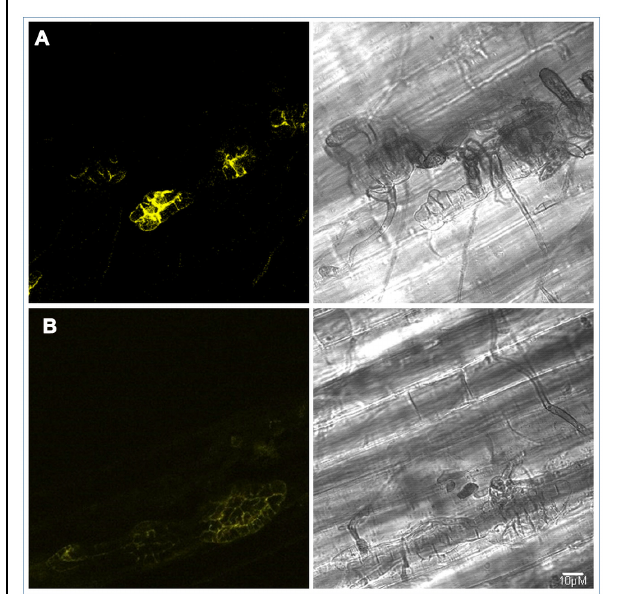
FIGURE 6 | PJK4:ALVi_Vi1_5: eYFP transformed isolate V. inaequalis Vi1 growing on apple hypocotyl viewed with bright field microscopy (right panels) and confocal fluorescent (left panels) 7 days post inoculation (A) and 14 days post inoculation (B). YFP fluorescence observed in multicellular, sub-cuticular stroma only. Fluorescent images are z